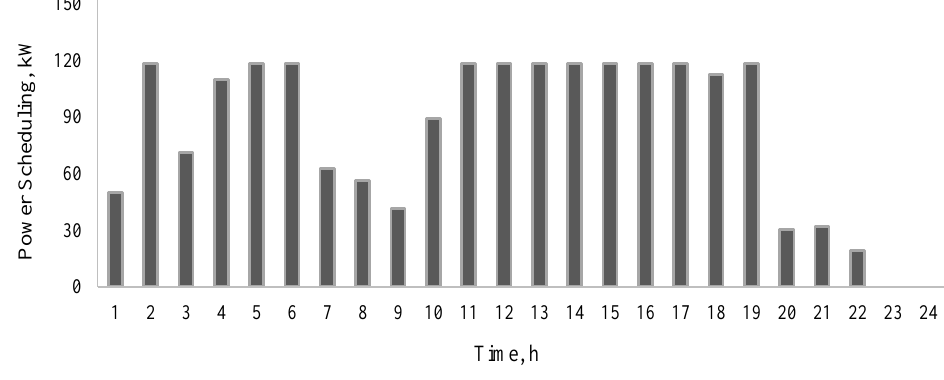
Figure 4. Power scheduling for swapping EV batteries at the